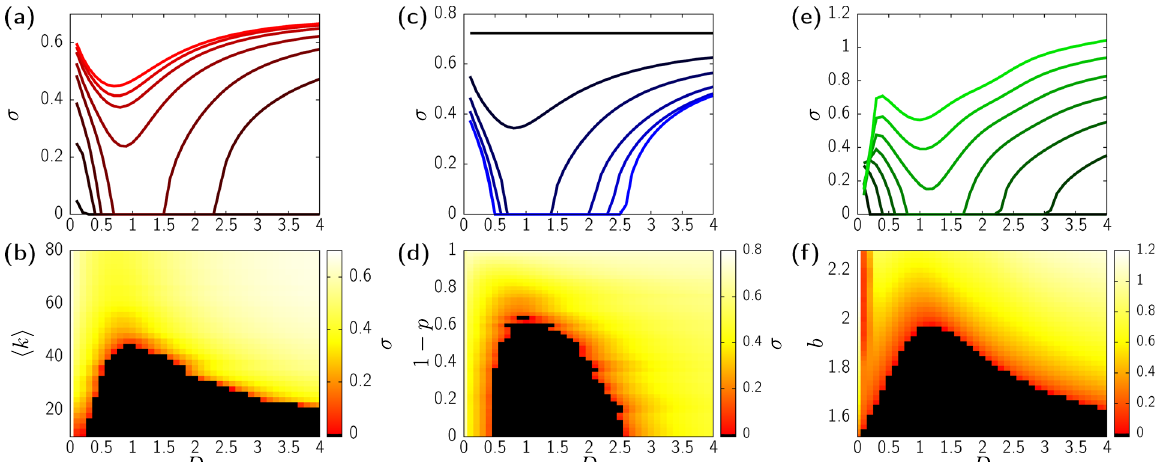
Fig. 5 Amplitude death and restoration dependence on different topological and system parameters. Top panels show the dependence of the amplitude of the mean- fi eld oscillations on the diffusion value D . Oscillation amplitude measured as the temporal standard deviation of the y variable ’ s mean- fi eld, σ ¼ σ ð y Þ . Each line corresponds to a speci fi c topological or system parameter value. Bottom panels show heatmaps of the amplitude upon tuning the diffusion and the corresponding parameter. Results obtained with simulations of the Brusselator model in networks with N = 1000 nodes and system parameters for the reaction terms a = 0.5 and b = 1.7 unless otherwise stated. a , b Dependence of the oscillation amplitude σ on the diffusion D in a range of Erdös-Rényi (ER) networks with different average degree k h i . Values of k h i for each curve in a are, from top to bottom, 80, 70, 60, 50, 40, 30, 20, and 10. c , d Dependence of the oscillation amplitude σ on the diffusion D for a range of Watts-Strogatz networks with average degree k h i ¼ 20 and rewiring probability p ∈ [0, 1]. Values of 1 − p for each curve in c are, from top to bottom, 1.0, 0.8, 0.6, 0.4, 0.2, and 0. e , f Dependence of the oscillation amplitude σ on the diffusion D for different values of the system parameter b with fi xed a = 0.5 in a single ER networks with 〈 k 〉 = 20. Values of b for each curve in e are, from top to bottom, 2.2, 2.1, 2.0, 1.9, 1.8, 1.7, and